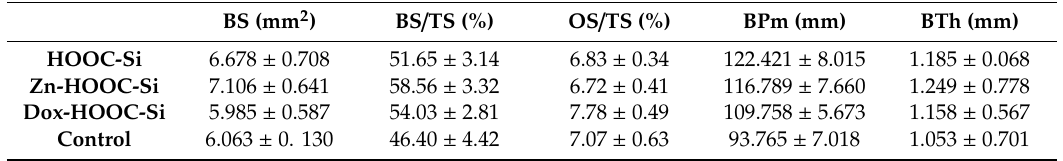
Table 1. Histomorphometric data obtained within the new bone created at the region of interest after Von Kossa staining (Mean ± Standard error).